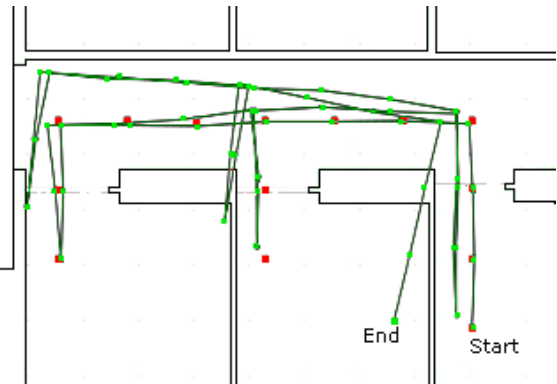
Figure 10. Estimated user position using only the IMU data. The small squares are user positions measured by the system; positions are directly calculated from the data provided by the IMU. The main line represents the link between sequential positions (squares) and are not meant to be interpreted as the estimated user position between those points. The final estimated user position is marked by the End